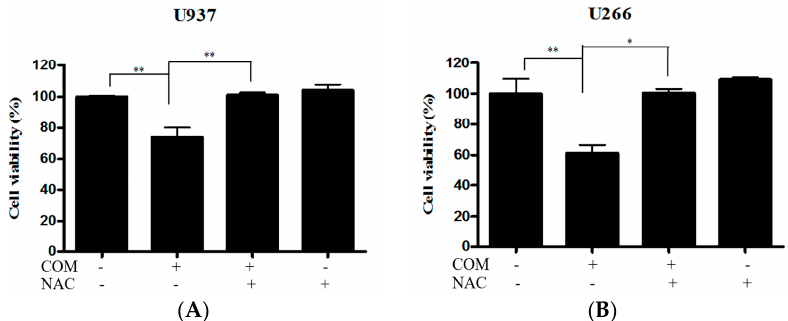
Figure 5. The effect of ROS scavenger on COM-induced apoptosis in U937 and U266 cells. ( A ) U937 cells were treated with COM (80 µg/mL) for 24 h with or without pre-treatment of NAC (5 mM) for 1 h. Cell viability was determined by EZ-cytox Enhanced cell viability assay kit; ( B ) U266 cells treated under the same conditions. Values represent the means of three experiments ± SD; * p < 0.05, ** p < 0.01, versus COM treated control.